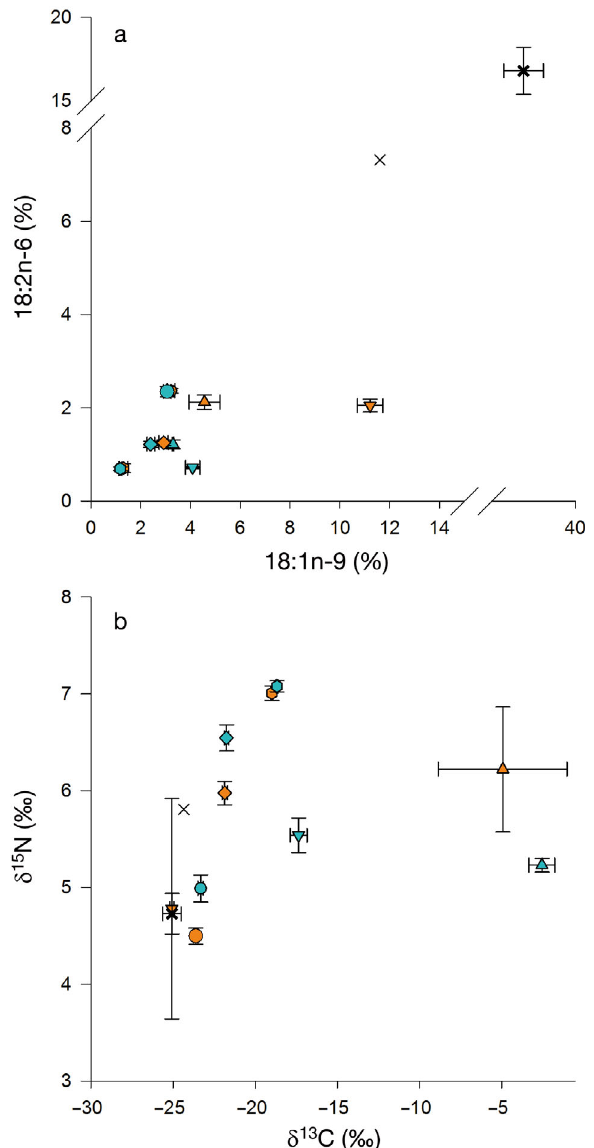
Fig. 2. Biomarkers for (a) terrestrial fatty acids 18:1n-9 and 18:2n-6, and (b) stable isotope ratios δ 13 C and δ 15 N. Error bars are SE. Symbols represent the source of aquaculture or- ganic effluent, diet  and fecal material ×, and biomarkers found in environment samples seston traps Z , sediment M , and king scallop Pecten maximus tissues, digestive gland d , gonad F , and muscle  , sampled from farm (orange)